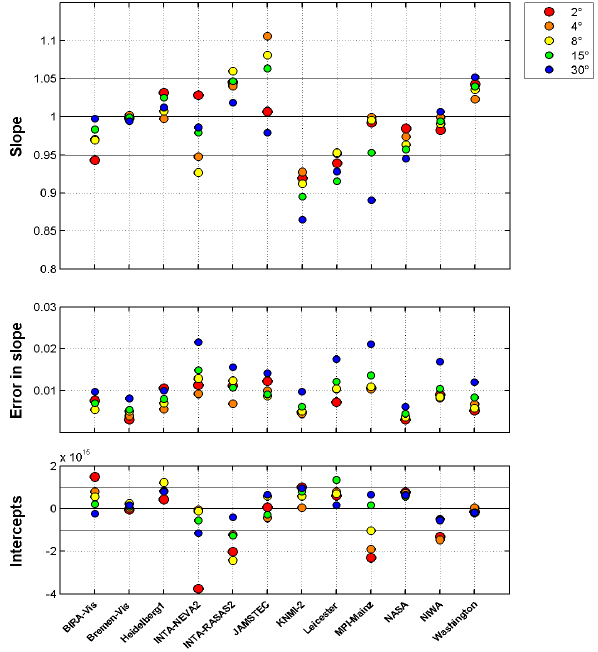
Fig. 11. Straight-line slopes and their standard errors and inter- cepts of NO 2 slant columns for each instrument participating in the semi-blind intercomparison at visible wavelengths against those of a reference data set. Colours refer to elevation angles shown in the top right legend. Note that the MPIC Mainz instrument used a non-standard wavelength range for spectral analysis because of the limited range of the instrument (Fig. 6 from Roscoe et al.,